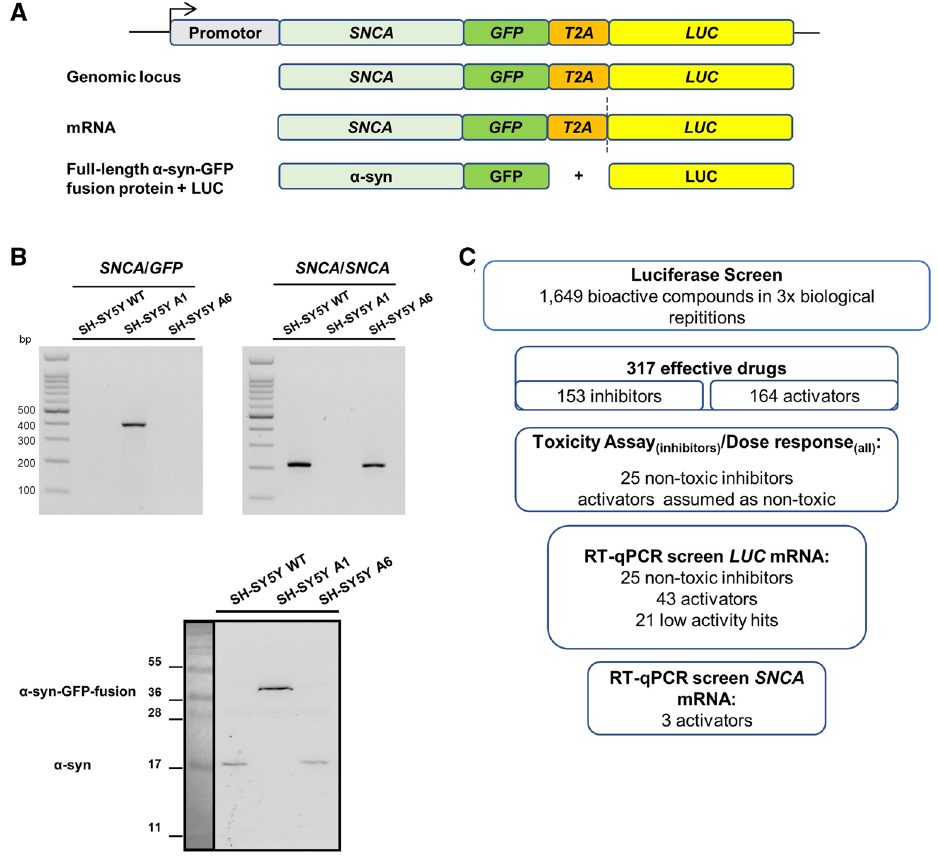
Figure 1. SNCA - GFP - LUC reporter cell line-based high throughput screening assay of 1649 FDA approved drugs identifies modulators of α-syn mRNA and protein levels. ( A ) Schematic overview of CRISPR/Cas9 generated, genomic SNCA-GFP-LUC fusion under control of the endogenous SNCA promotor in the SH-SY5Y cell line. Translation of its mRNA results in both, α-syn-GFP fusion protein and a functional LUC protein, separated by a ribosome skipping event due to the T2A sequence. ( B ) Agarose gel-electrophoresis of PCR from cDNA (top) and Western blot (bottom) of the reporter cell line confirming in-frame SNCA - GFP - LUC fusion at mRNA- and α-syn-GFP at protein level, respectively. ( C ) Workflow of the screening and validation procedure of α-syn modulating drugs. Several exposure images of full-size WB in ( B ) (lower panel) see Supplementary Fig.